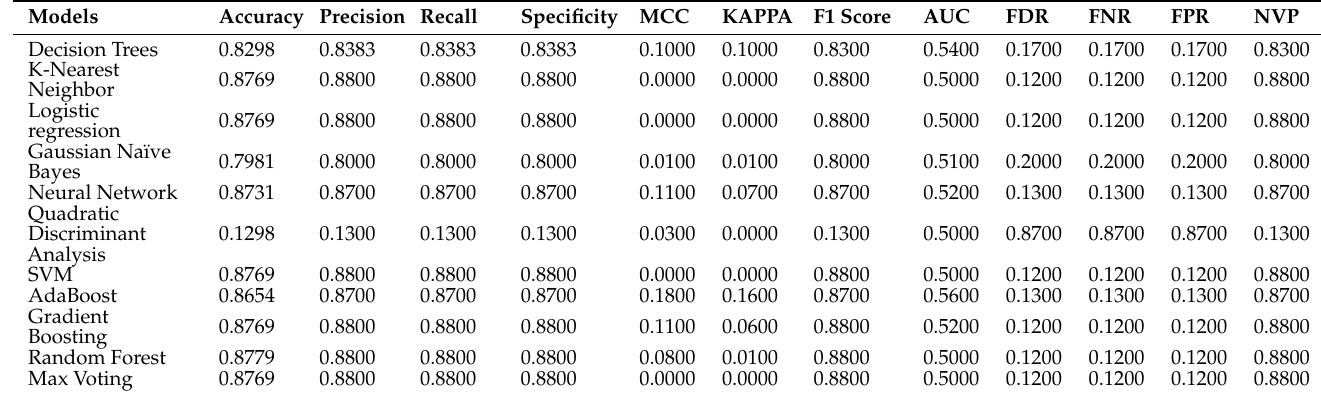
Table 5. Result of Dataset 2 using the Machine Learning Algorithms and Ensemble learning